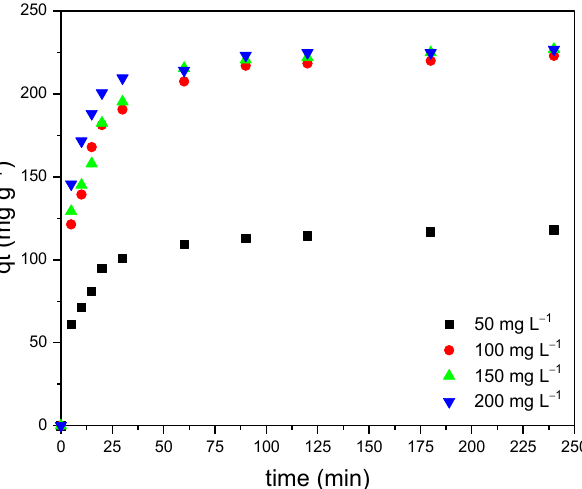
Figure 4. Effect of contact time (0–240 min) on MB adsorption on CXTi synthesised in this study, at initial concentrations of 50, 100, 150 and 200 mg L − 1 . Note: Error bars are negligibly small, hence the overlap of the limits.